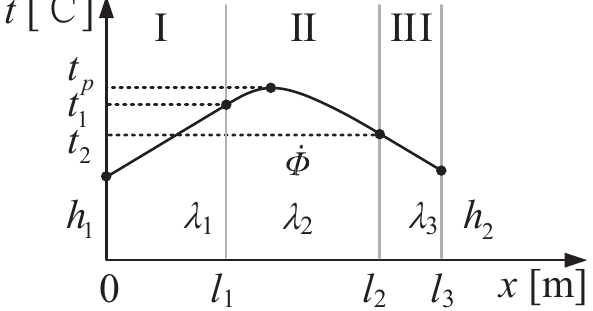
Figure 1. Typical case of heat conduction and diffusion.